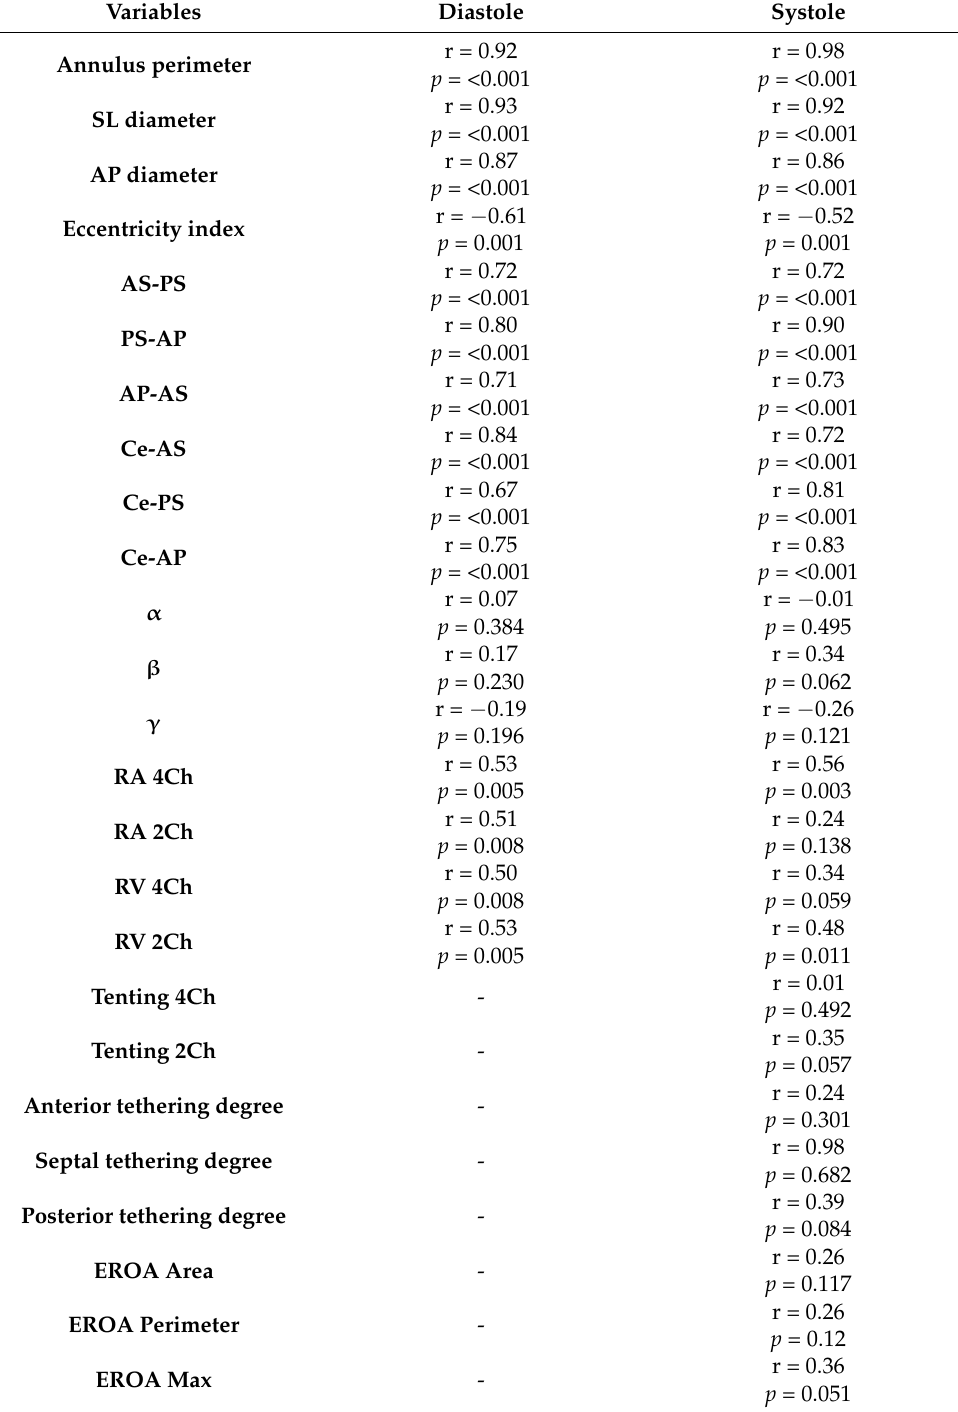
Table 3. Pearson correlation between CT variables and annulus